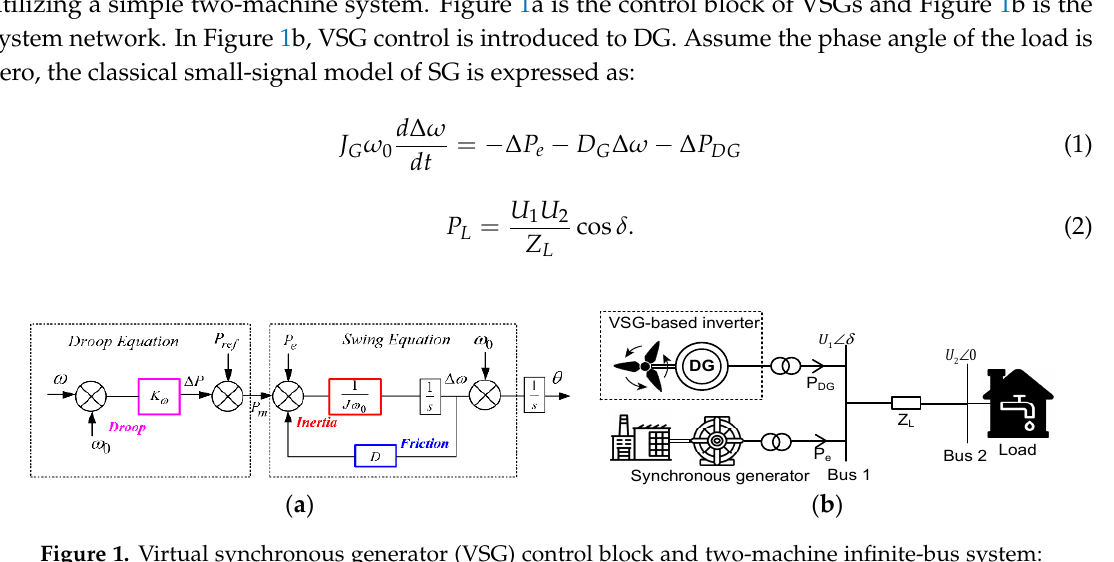
Figure 1. Virtual synchronous generator (VSG) control block and two-machine infinite-bus system: ( a ) the control block of VSG; ( b ) the two-machine infinite-bus system.